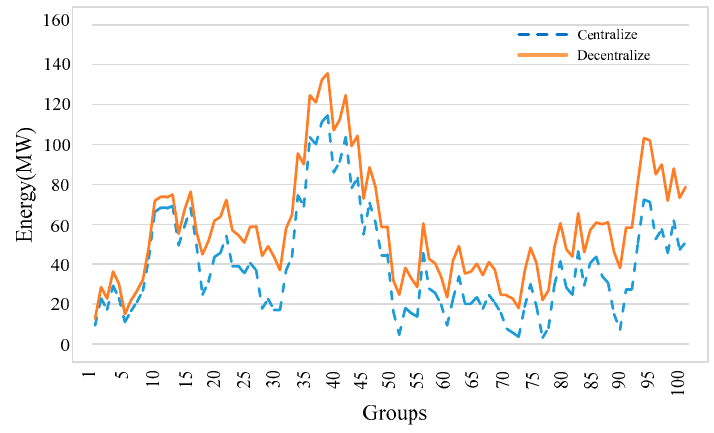
Figure 30. A comparison results of storage energy between the centralized control and the decentralized control.